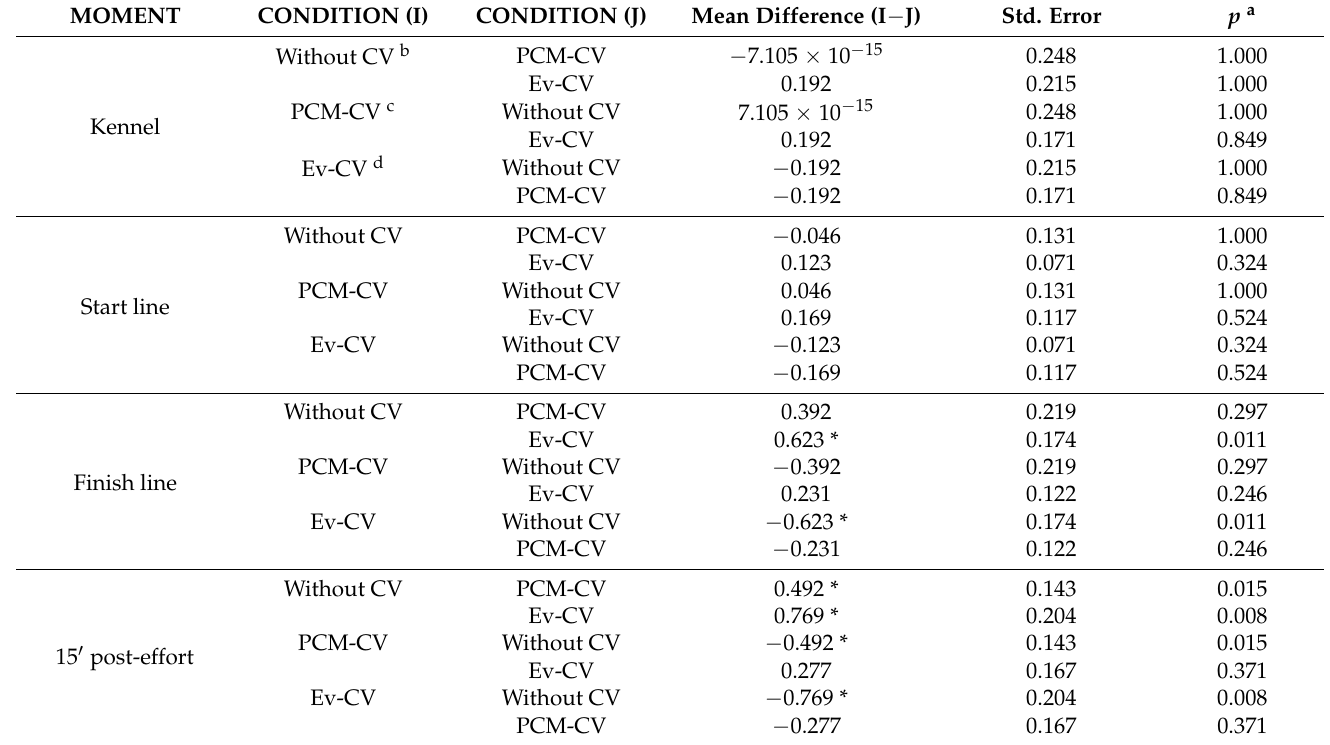
Table 8. Pairwise comparisons isolating the MOMENT factor. Measurement: